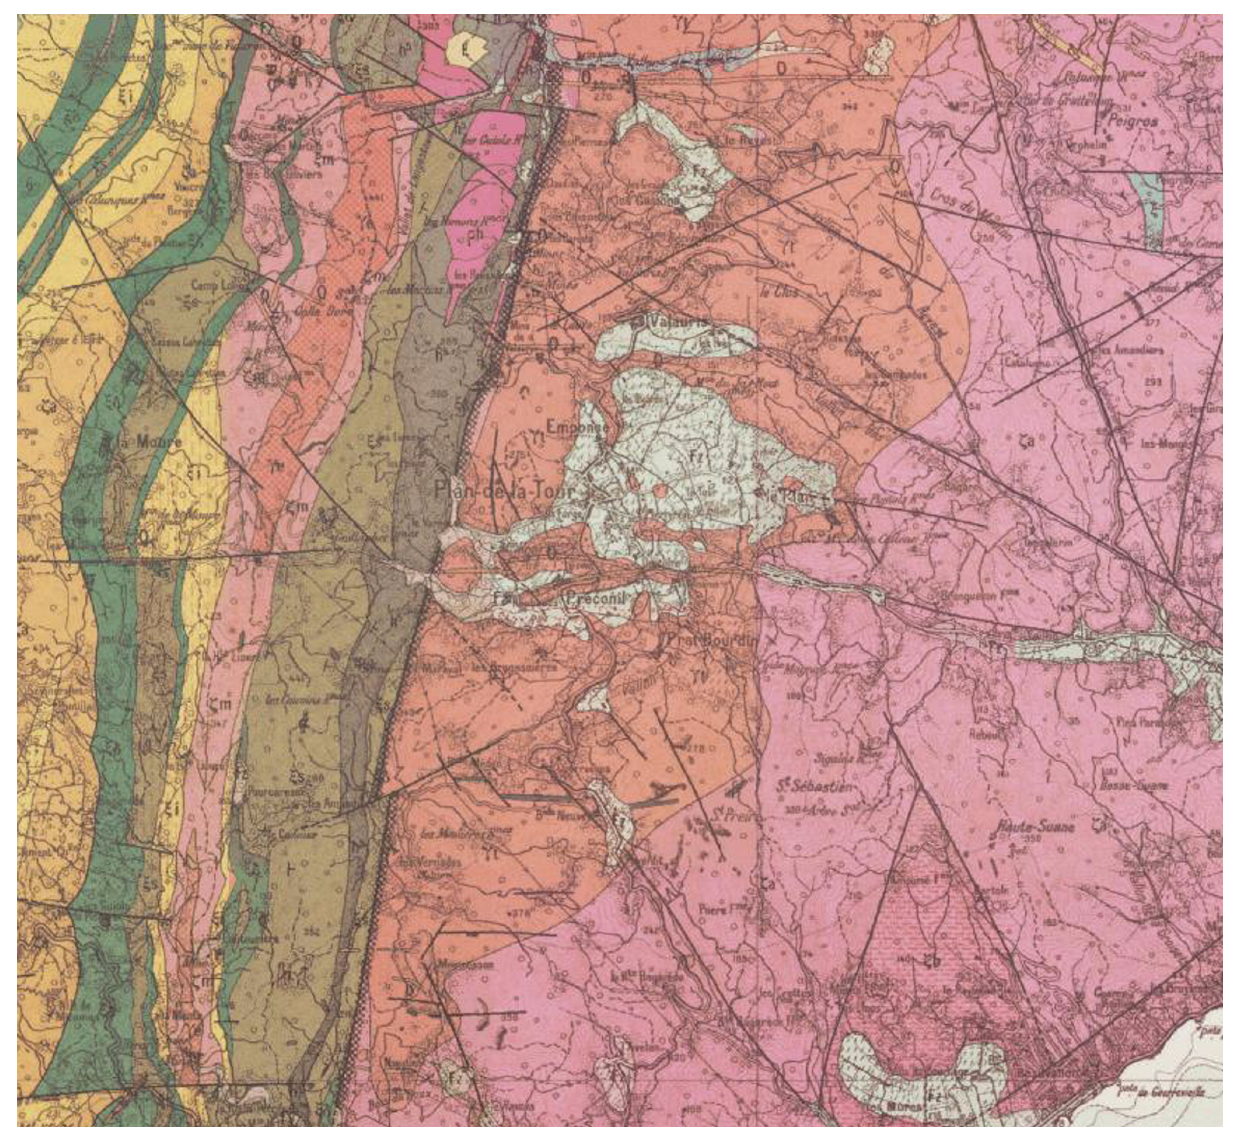
Figure A1. Geological map of the granite of Le Plan de la Tour (Maures, South of France), represented by the north–south elongated red zone in the center of the geological map (source https://www.geoportail.gouv.fr/carte, last access: 19 January 2022).